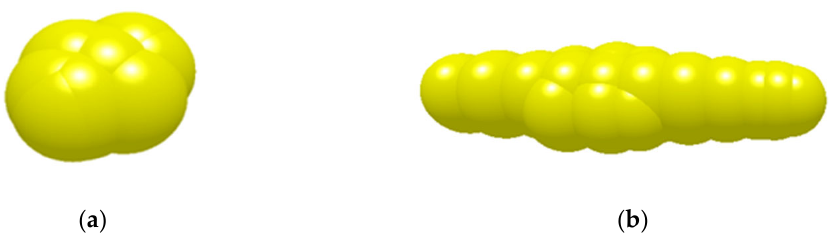
Figure 3. Discrete element model of seeds. ( a ) Vetch seeds model; ( b ) Oat seed model. Table 1. Computational parameters used in the simulations.